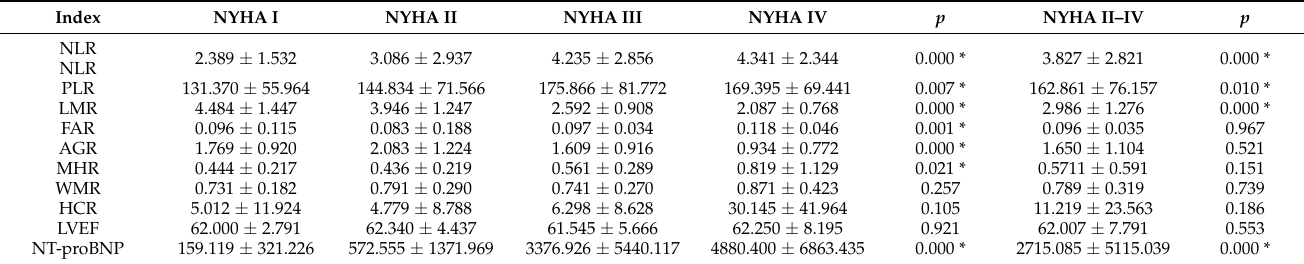
Table 2. Comparison of SII levels in different cardiac function groups.